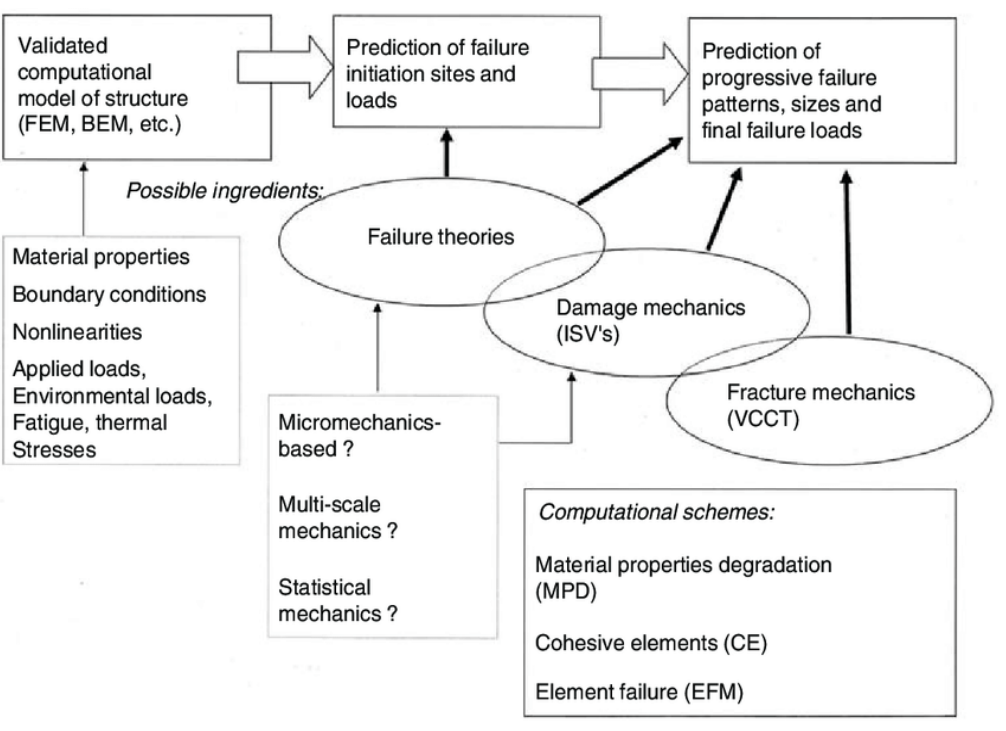
Figure 5. Modelling impact scenario.